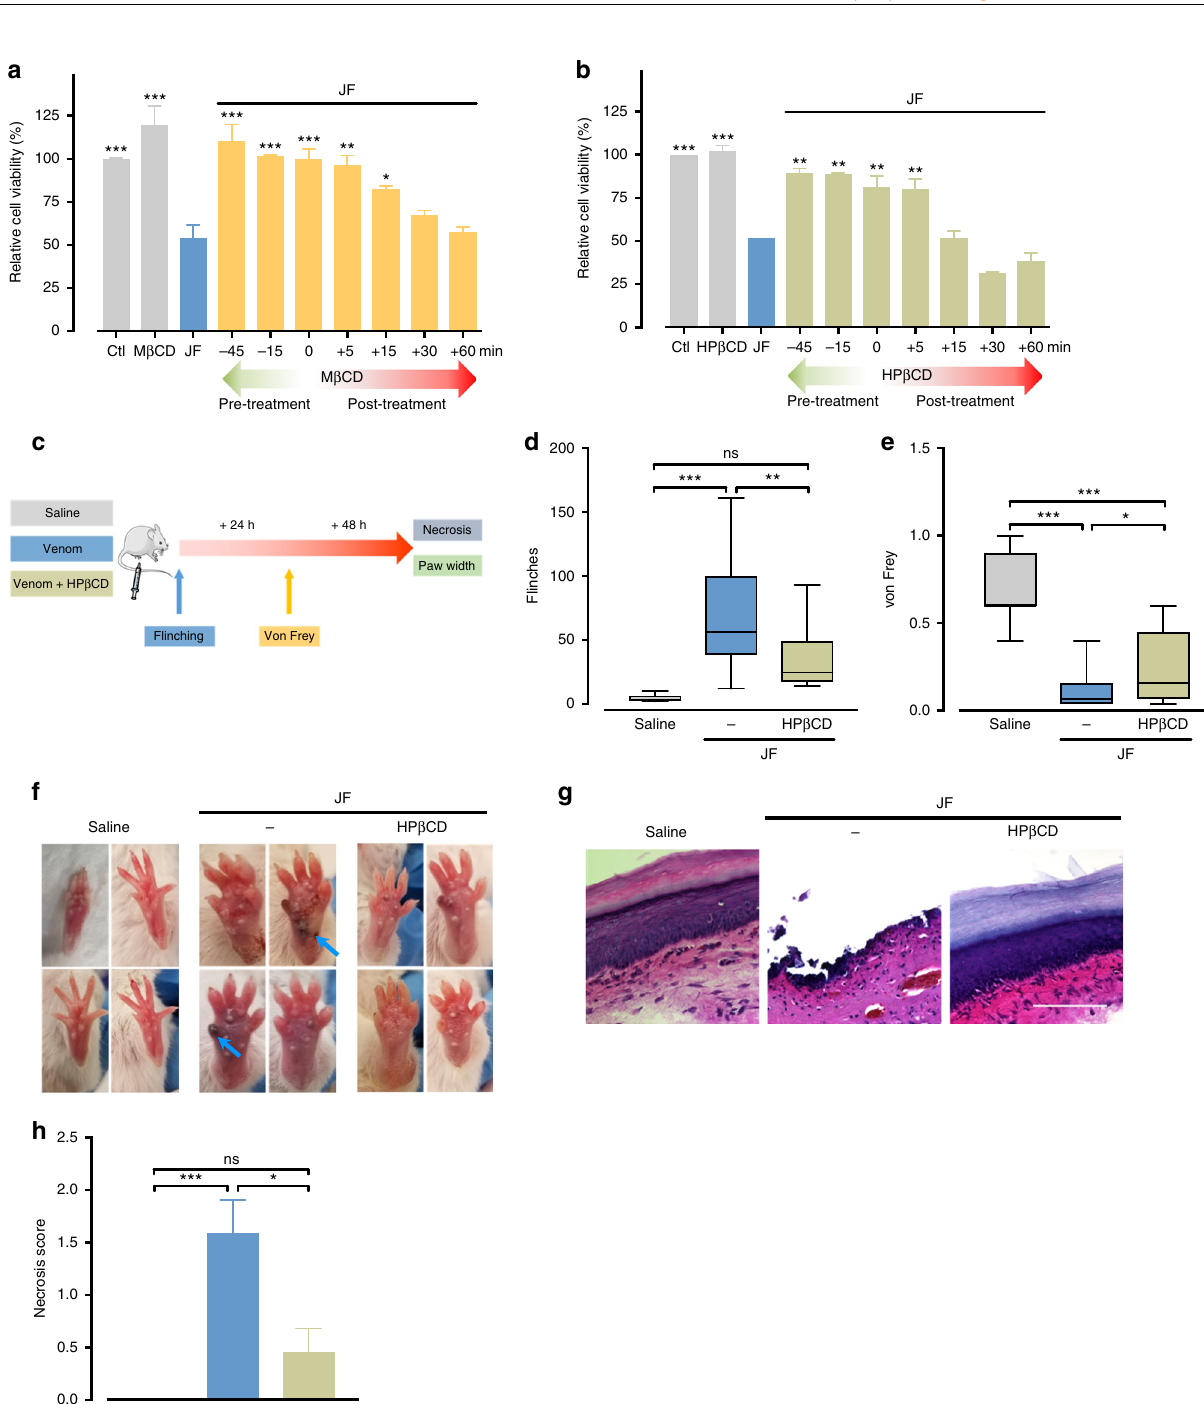
Fig. 7 M β CD and HP β CD are potential box jelly fi sh venom antidotes. a , b Comparison of pre-treatment and post-treatment of a M β CD and b HP β CD in protection from jelly fi sh venom (0.75 µ g/ml) in HAP1 cells ( n = 3). Signi fi cance was assessed using one-way ANOVA followed by Tukey ’ s post hoc test, * p < 0.05; ** p < 0.01; *** p < 0.001. c Schematic design of the in vivo study. This schematic fi gure was built using mouse templates available from the Servier Medical Art, which are licensed under a Creative Commons Attribution 3.0 Unported License; [https://smart.servier.com]. d , e Box plots showing pain response from d fl inching behaviour and 50% paw withdrawal threshold e in von Frey test for mechanical hypersensitivity on mice treated with intraplantar injection of jelly fi sh venom alone or venom co-injected with HP β CD ( n = 7 – 16; center line, median; box limits, upper and lower quartiles; whiskers, max to min). f HP β CD can suppress local tissue necrosis caused by injection of intraplantar jelly fi sh venom. g Haemotoxylin and Eosin staining of mouse footpad sections in control (Saline), venom treated (JF) and venom with HP β CD (JF & HP β CD) validating that venom treatment caused tissue necrosis. Scale bars are 100 µ m. h quanti fi cation of venom necrosis in ( f ), Kruskall – Wallis followed by Dunn ’ s post hoc test, * p < 0.05; ** p < 0.01; *** p < 0.001; ns, not signi fi cant. All data represented as mean ±